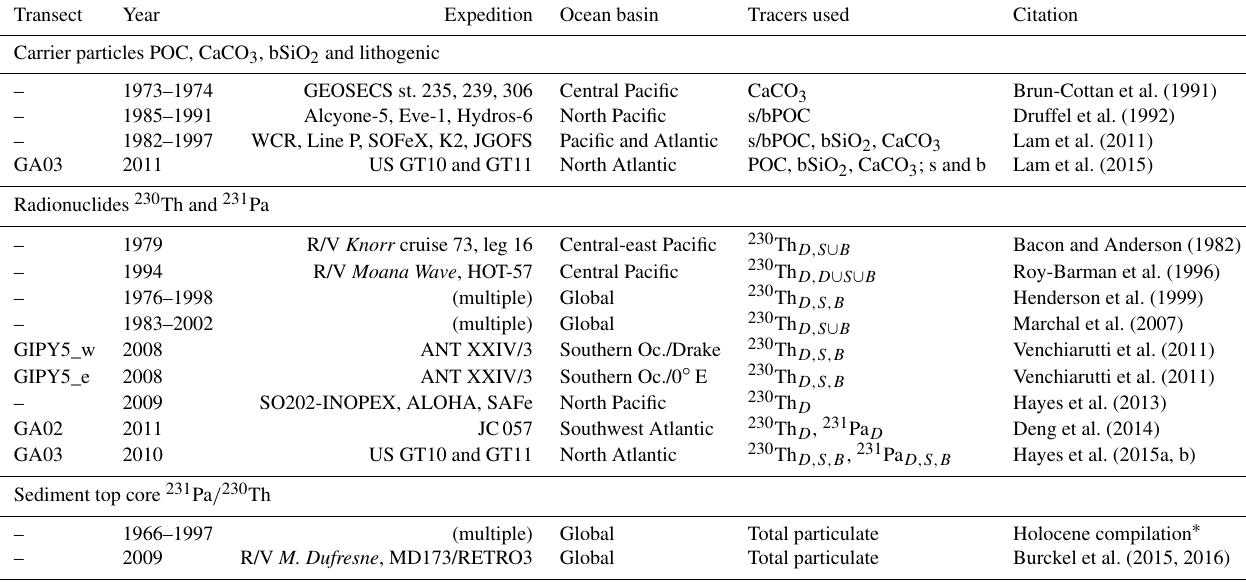
Table 3. Observations used for comparison with the model simulations.